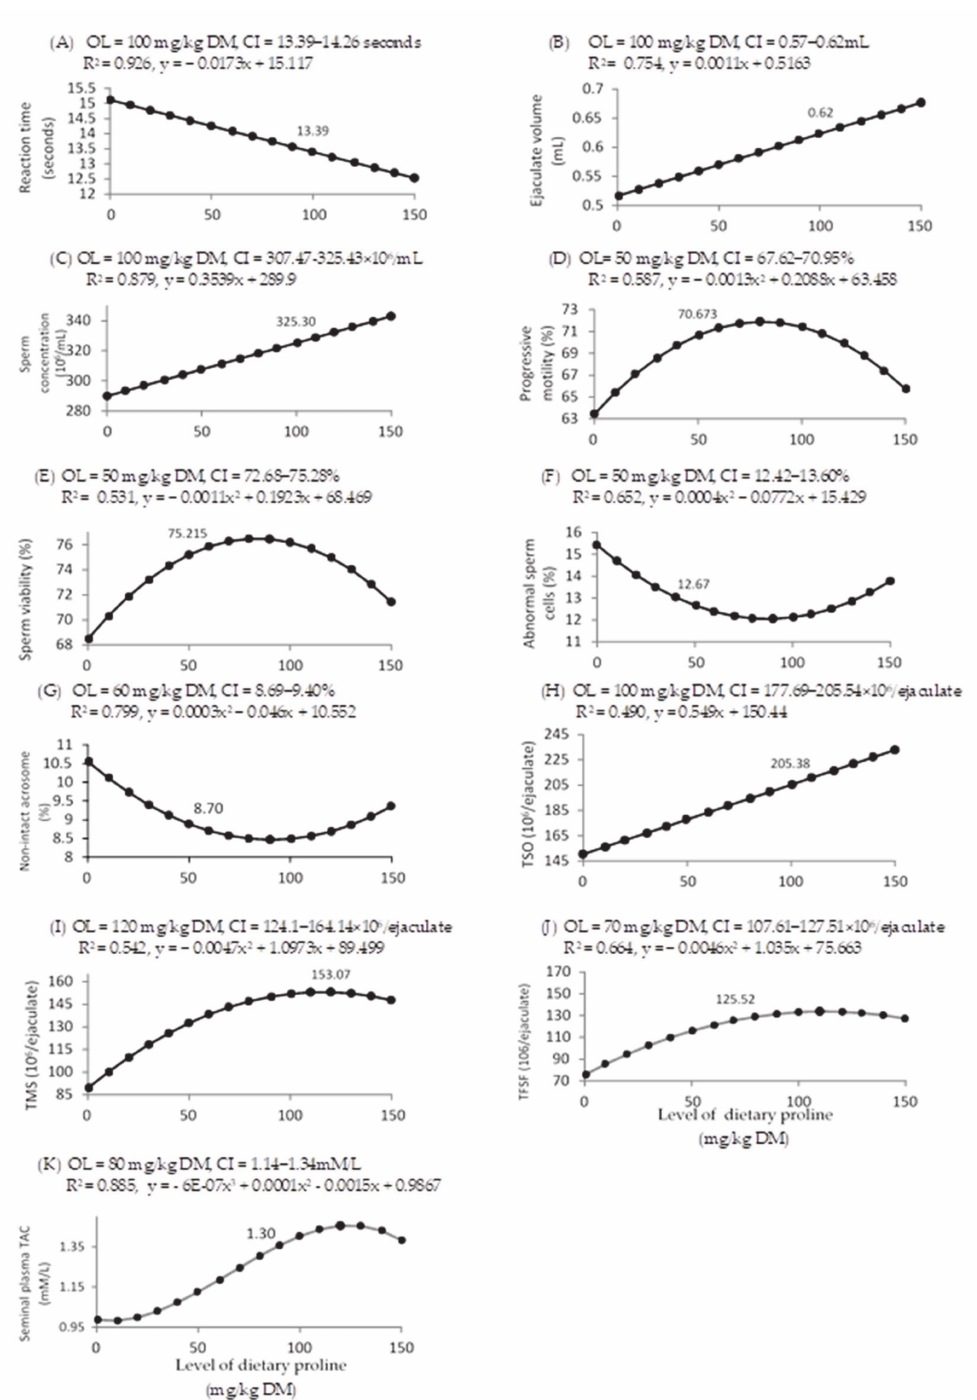
Figure 4. Dose–response curve of reaction time ( A ), ejaculate volumen ( B ), sperm concentration ( C ) and percentages of motile sperm cells ( D ), viable sperm cells ( E ), normal sperm cells ( F ), non-intact acrosome sperm cells ( G ), total sperm output (TSO, ( H )), total motile sperm count (TMSO, ( I )), total functional sperm fraction (TFSF, ( J )), and seminal plasma antioxidant capacity (TAC, ( K )) for different levels of dietary supplemental proline. DM = dry matter, OL = optimum level of dietary supplemental proline, CI = confidence interval, R 2 = regression value, and x and y are the dependent variable (proline level) and the independent variable of the regression equation, respectively. The figure only shows significant ( p < 0.05)